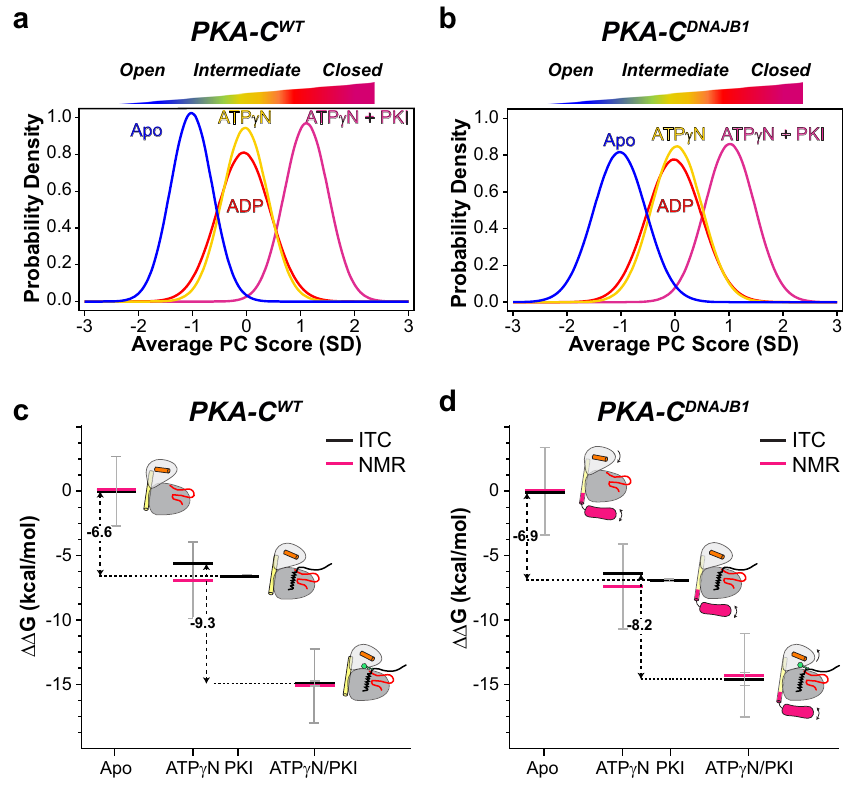
Fig. 5 Global coordinated response of PKA-C WT and PKA-C DNAJB1 to ligand binding. Coordinated chemical shift changes analyzed with CONCISE for a PKA-C WT and b PKA-C DNAJB1 . Changes in the free energy of binding of c PKA-C WT and d PKA-C DNAJB1 to ATP γ N and PKI 5 – 24 . Black lines indicate the values obtained from ITC and pink lines correspond to values obtained from NMR